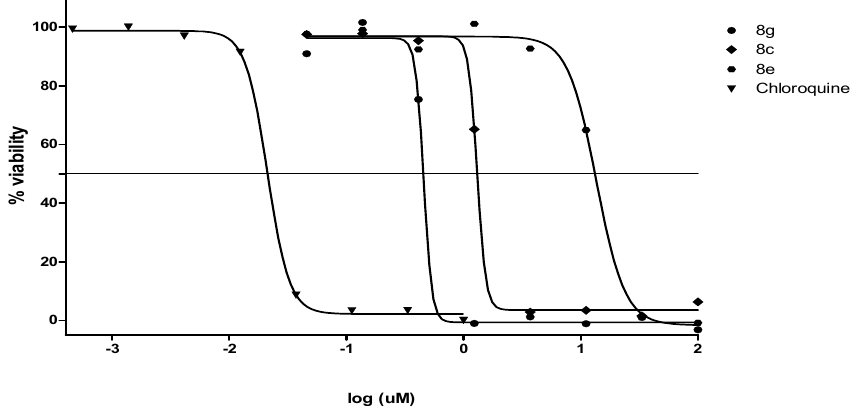
Figure 3. Dose-response curves of compounds active against P. falciparum compared with